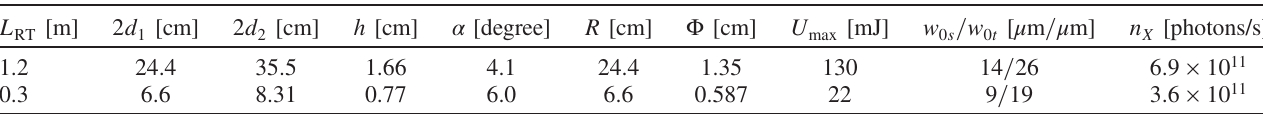
. See text for details. RT